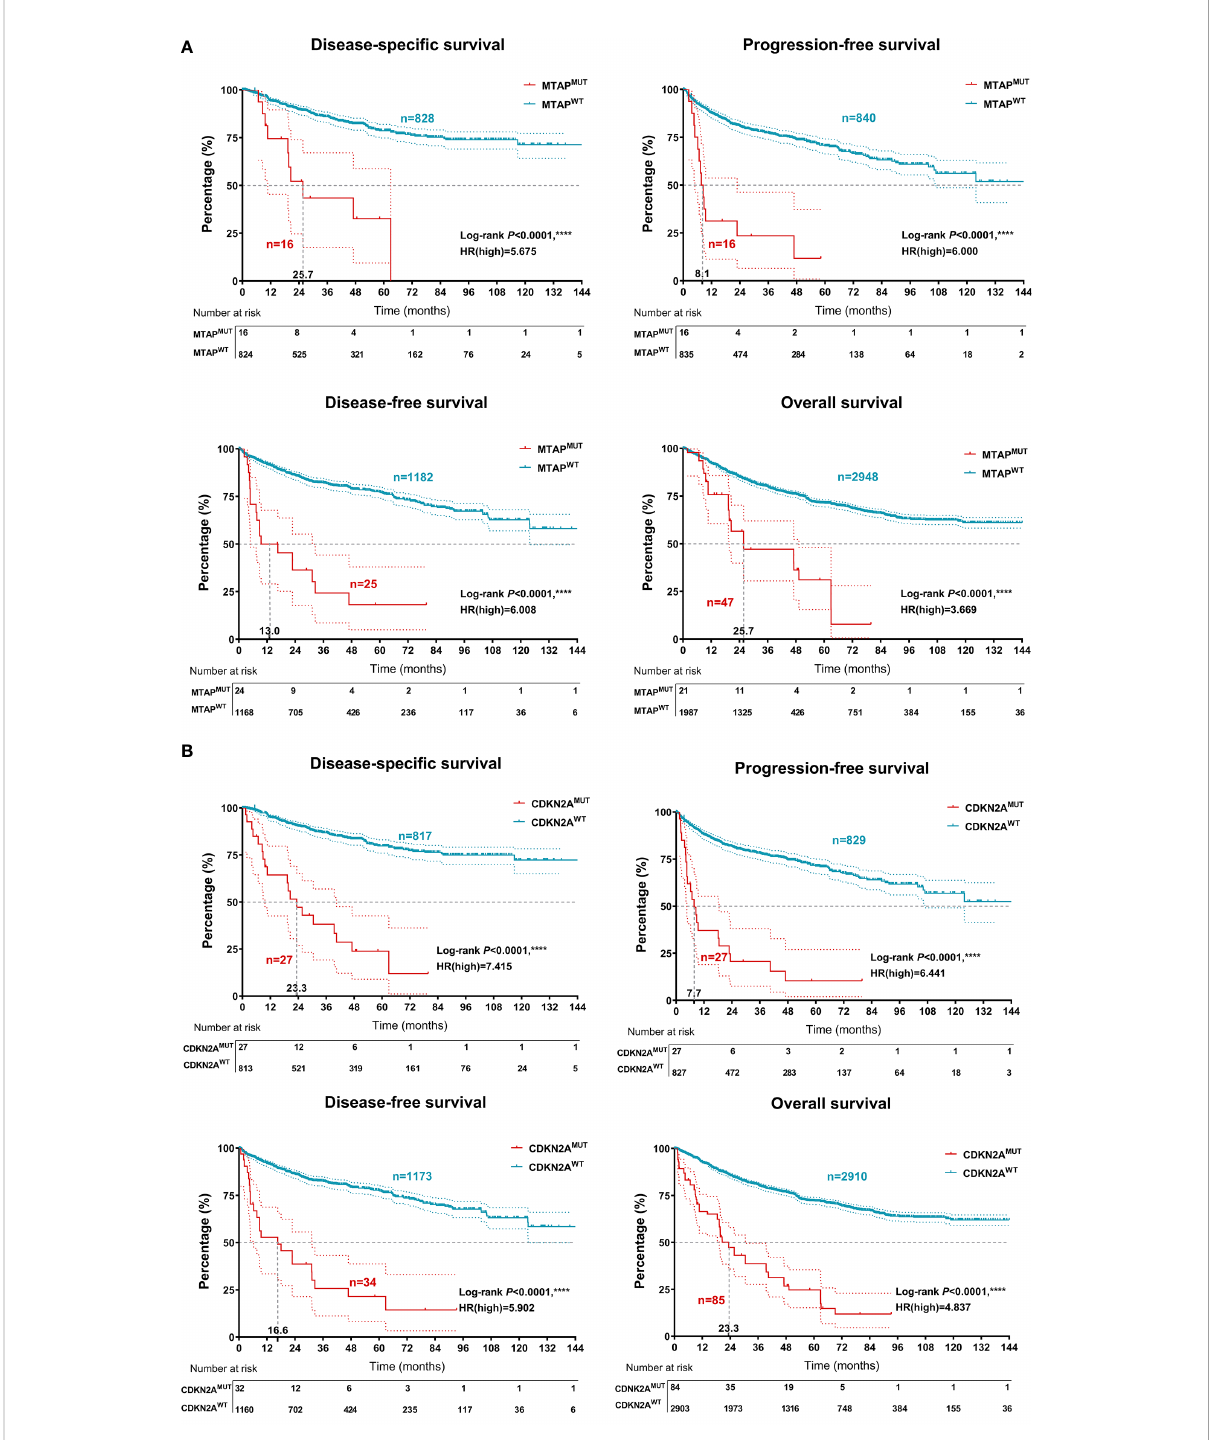
FIGURE 3 Prognostic implications of MTAP MUT and CDKN2A MUT 3,563 patients with RCC from the testing set of the Western cohort. (A) Classi fi ed by the MTAP / CDKN2A MUT , disease-speci fi c survival, PFS, disease-free survival, and OS of RCC patients from the Western cohort using Kaplan – Meier survival analysis. (B) Association between MTAP / CDKN2A MUT and clinicopathological characteristics, association between MTAP / CDKN2A MUT and hemogram, and association between MTAP / CDKN2A MUT and clinical therapeutic ef fi cacy. ****,